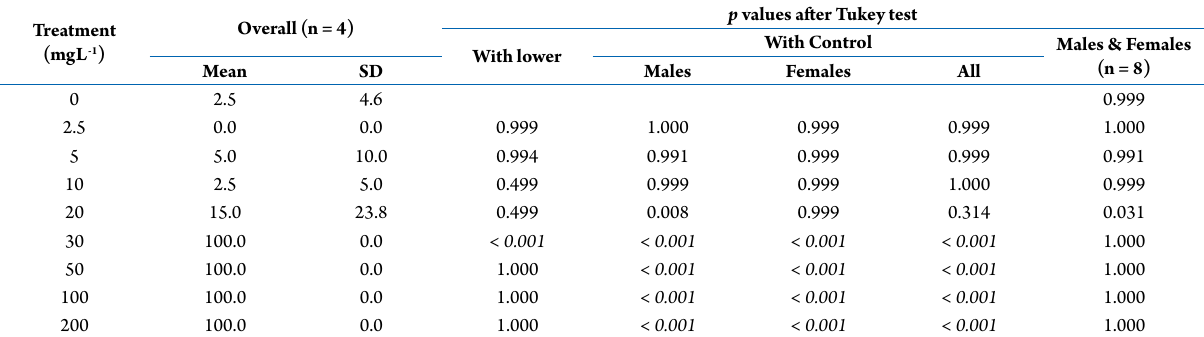
Table 1. Results of Tukey’s test of pair-wise mean comparisons between MMS-treated and control units, with the immediately anterior lower MMS concentration and between genders at each concentration (non-protected test). p values after Tukey test Overall (n = 4) Treatment With Control Males & Females (mgL -1 ) With lower